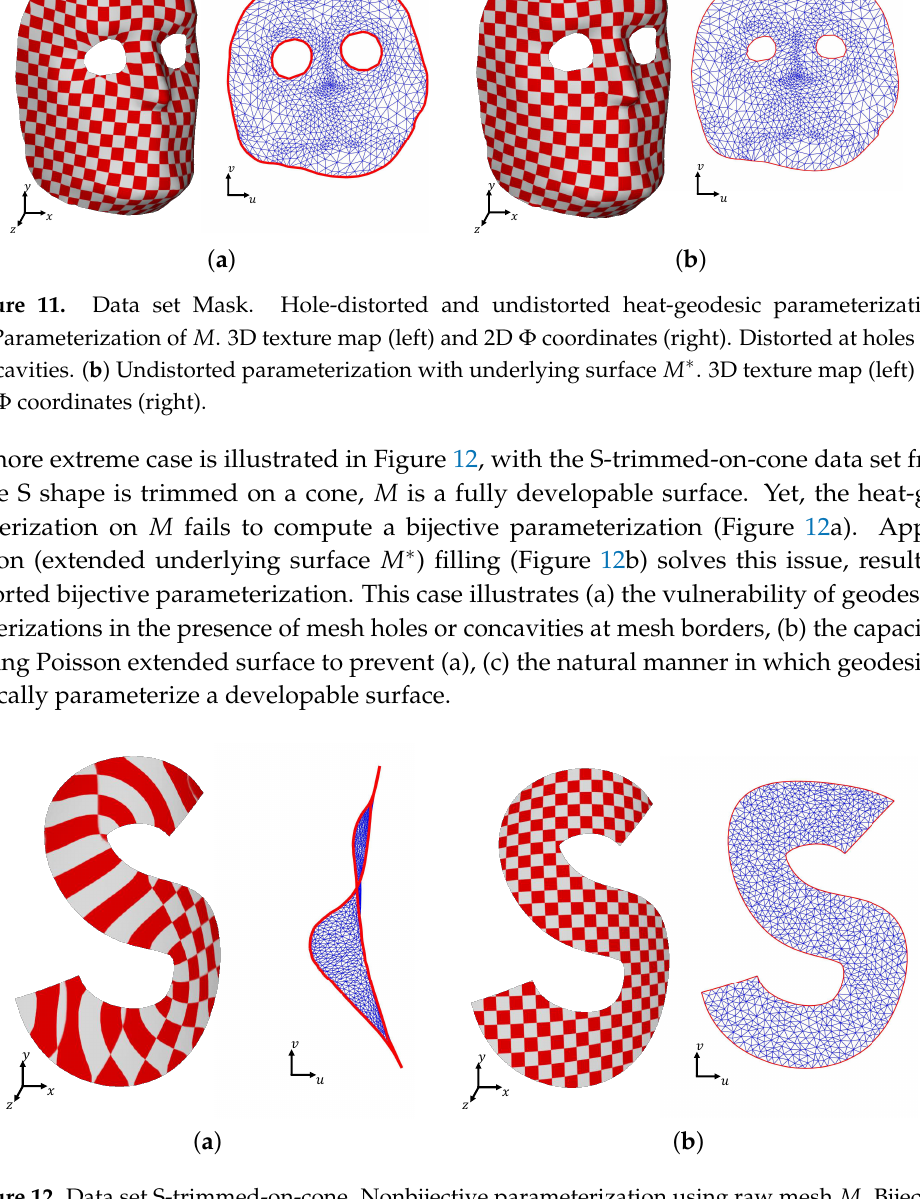
Figure 12. Data set S-trimmed-on-cone. Nonbijective parameterization using raw mesh M . Bijective isometric parameterization using underlying Poisson mesh M ∗ . ( a ) Nonbijective parameterization of M . 3D texture map (left) and 2D Φ coordinates (right). ( b ) Undistorted and bijective parameterization with underlying surface M ∗ . 3D texture map (left) and 2D Φ coordinates